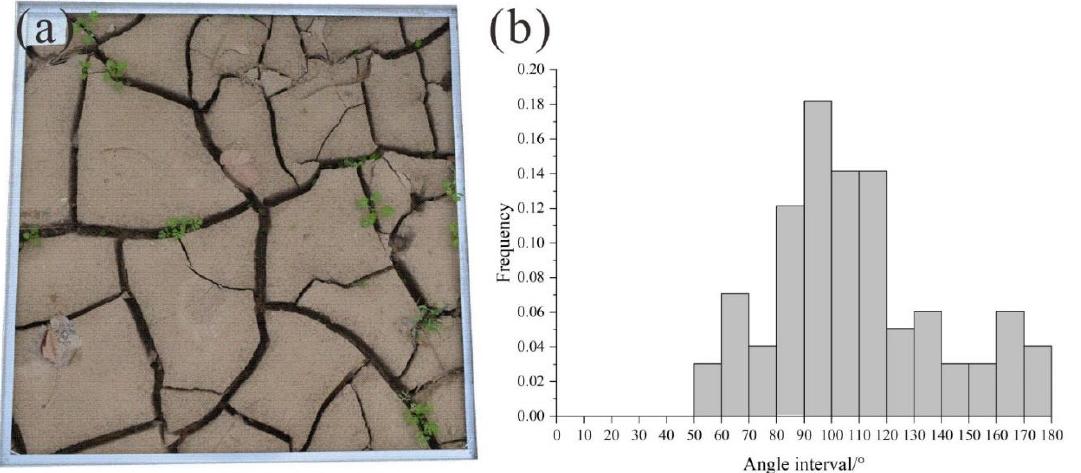
Figure 13. Angel distribution of desiccation cracks in nature. ( a ). Desiccation cracks in the Yellow River of the Huayuankou area in Zhengzhou City. (The white frame is 1 × 1 m 2 ). ( b ). statistical analysis of cracks angle.